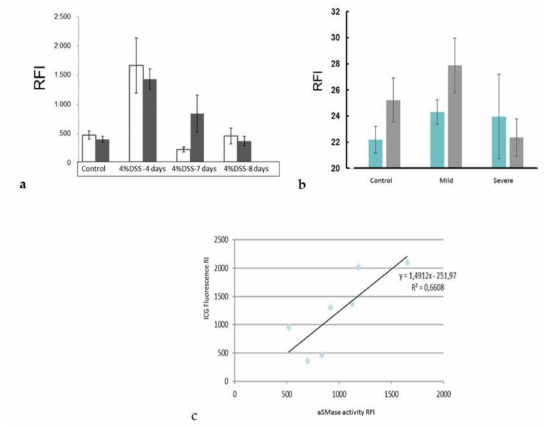
Figure 4. The inflammation targeting of the ICG loaded SM-liposomes was studied ex vivo from dextran sodium sulfate (DSS)-treated animals ( a ). The mice were treated with 4% DSS in drinking water for five days, and then regular water was given until the endpoint. Animals were sacrificed on days four, seven, and eight. Healthy non-treated animals were used as a control. The liposomes (125 µ L 20 mM total lipid in PBS) were added via tail vein injection to the animals (n = 4 per disease group and control group). The mice were sacrificed, and the ICG fluorescence was analyzed from the proximal colon (dark column) and distal colon (white column) ex vivo 24 h after tail vein injection using a Night Owl Imager. Regions of Interest (ROIs) were drawn around two colon segments (proximal and distal colons) and were analyzed with the indiGO software. Y-axes represent Relative Fluorescence Intensity (RFI). Bars represent mean ± SEM. The targeting of the ICG- loaded SM-liposomes was verified by analyzing the ICG fluorescence from histological slices ( b ). The proximal (blue) and distal (grey) colon samples were collected and cut into 10 µ m thin section slices. The fluorometric scanner was used to measure the ICG fluorescence from the thin section slices. Bars represent mean ± STDEV. Correlation between the aSMase activity ( x -axel) and targeted ICG fluorescence (y-axel) was analyzed ( c ). The ICG fluorescence was measured from proximal colon samples using a Night owl Imager; ROIs were drawn around proximal colon samples and were analyzed with the indiGO software. The homogenate samples were collected from the same proximal colon samples, and aSMase activity was analyzed using an Amplex Red acid sphingomyelinase assay kit. The Amplex fluorescence was standardized to the tissue weight (mg). All the tissue sample activities were analyzed